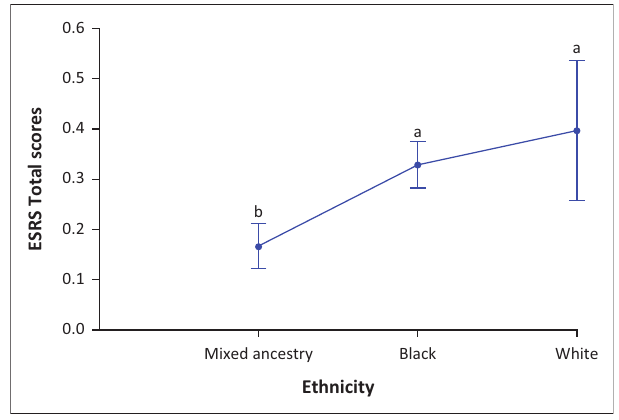
FIG URE 2: Total Extrapyramidal Symptom Rating Scale scores by ethnicity.